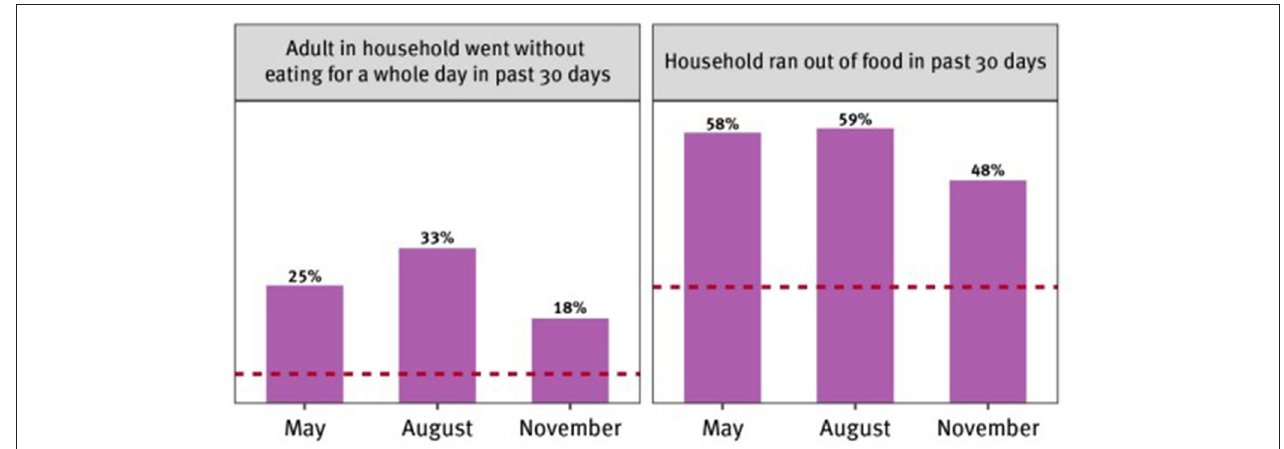
FIGURE 1 | Hunger during the pandemic. Source: Human Right Watch analysis of the NBS 2020 COVID-19 phone survey.